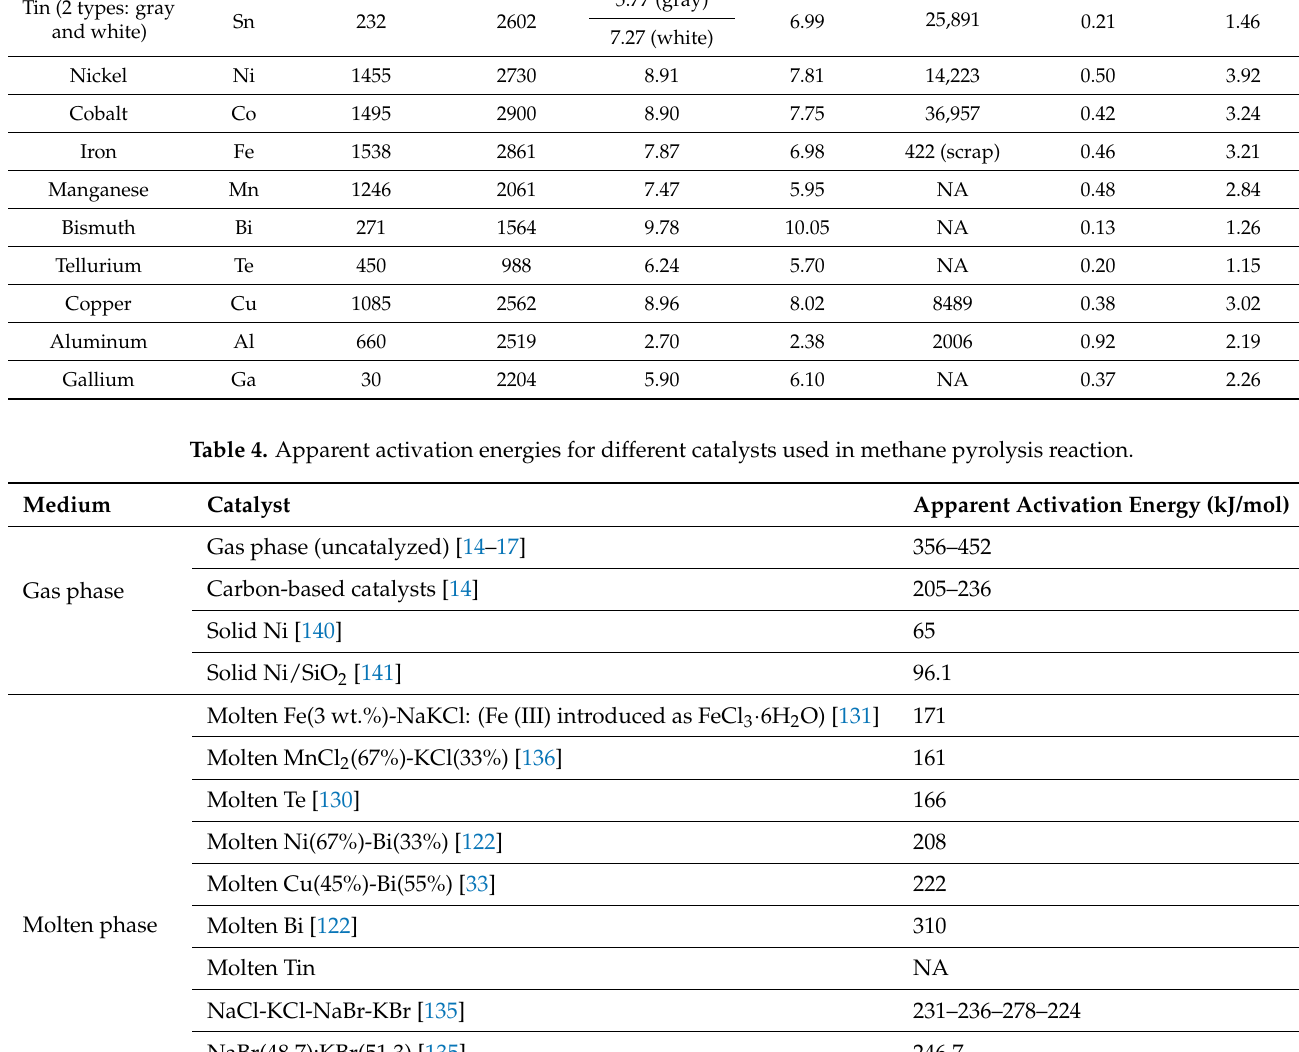
Table 3. Main metal properties with calculated volumetric heat capacity (LME: London metal exchange) [138,139]. Metal